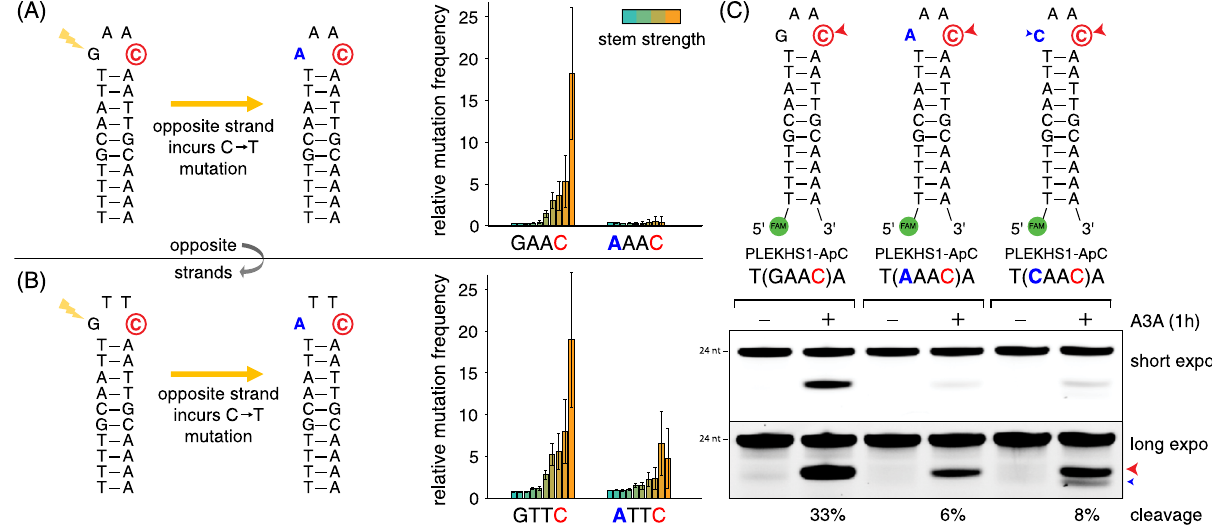
Fig. 6 Twin mutation hotspot combining optimal TpC and VpC sites. A twin mutation hotspot detected in the gene PLEKHS1 contains an optimal hairpin substrate on each strand of the DNA. A On one DNA strand, the hairpin contains the sequence GAAC, and the C in last position is an optimal VpC substrate for A3A. B On the other DNA strand, the hairpin contains the sequence GTTC, and the C in last position is an optimal TpC substrate for A3A. However, when A3A generates a mutation at either strand ’ s site, and the cell goes through DNA replication, then the mutation becomes propagated to the complementary strand, in the fi rst (5 ’ ) position of the loop. This mutation causes the local sequence context to no longer be optimal, leading to a decrease in the observed mutation frequency in tumors (bar plots). Error bars represent 95% con fi dence intervals. C In vitro APOBEC3A assay con fi rms activity at GAAC hairpin loop sequence. Changing to AAAC or CAAC reduces the substrate optimality by corrupting the optimal GAAC sequence. Source data are provided as a Source Data fi